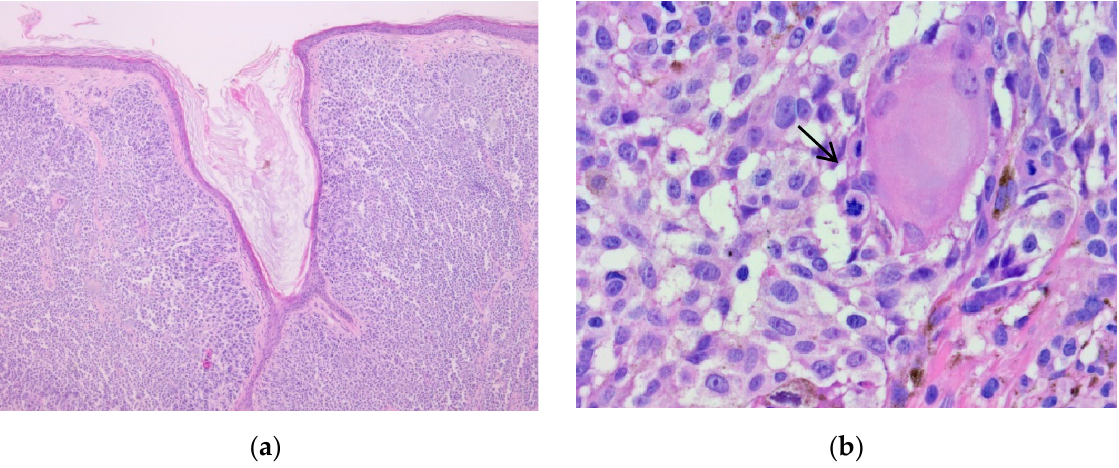
Figure 5. Nevoid melanoma. ( a ) Tumor architecture, 5× magnification. ( b ) Deep area of the tumor showing lack of maturation. Enlarged, atypical tumoral cells are observed, presenting prominent nucleoli. Mitoses are highlighted in the field (arrow), 40× magnification. (Collection of Pathology Department SCJ Mure ș ).